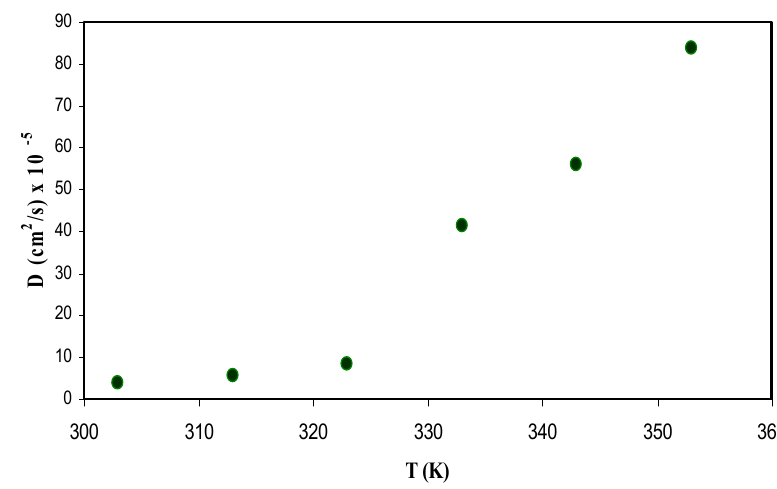
Figure 11. Diffusion coefficient of ions versus temperature for the CS: POZ: MgTfsystem. Figure 11. Di ff usion coe ffi cient of ions versus temperature for the CS: POZ: MgTfsystem.